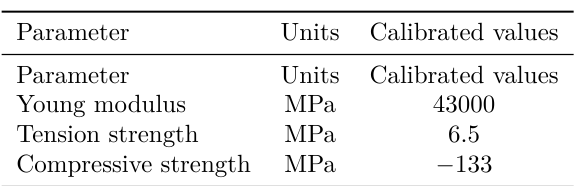
Table 2. Calibrated values of the key material pa- rameters based on the CMOD analysis.